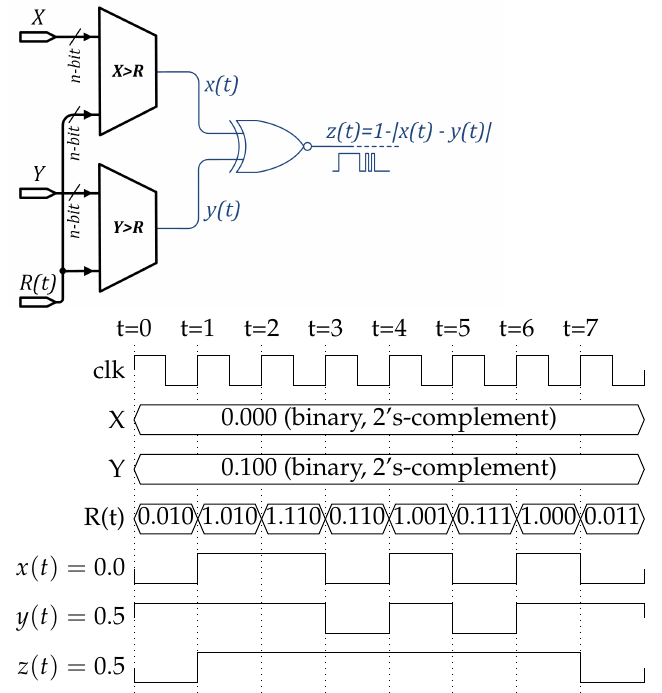
Figure 5. Correlation between signals can change the function implemented by logic gates. Stochastic signals x ( t ) and y ( t ) are said to be perfectly correlated when they share the same RNG R ( t ) . Stochastic signals are noted in